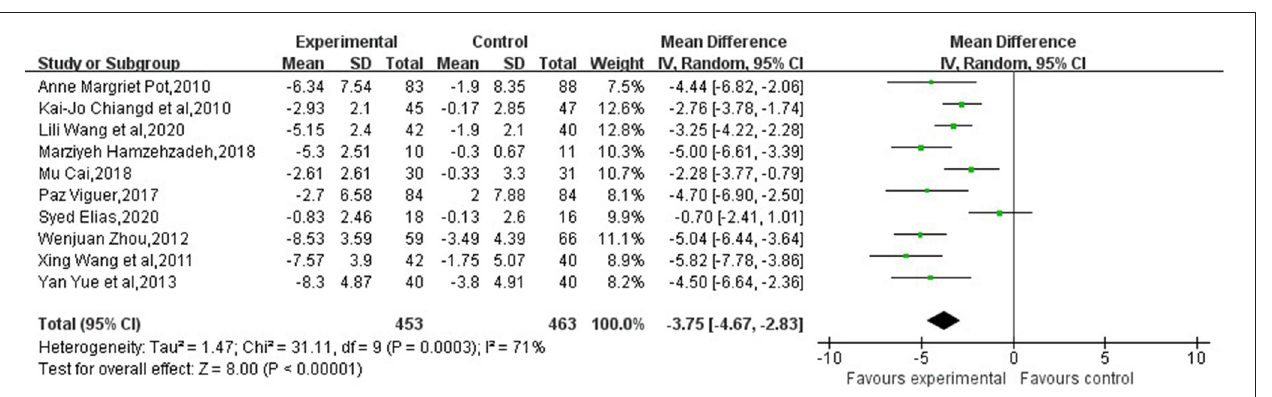
FIGURE 3 | Forest plot of the overall effect of reminiscence therapy on relieving depressive